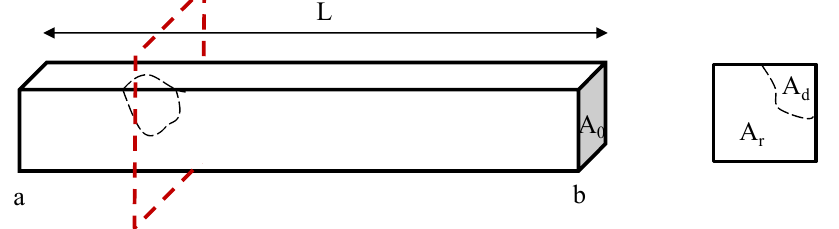
Figure 3. Damage that was introduced in a strut is illustrated, and the strut representative ( σ s ) con- ductivity could be further calculated.